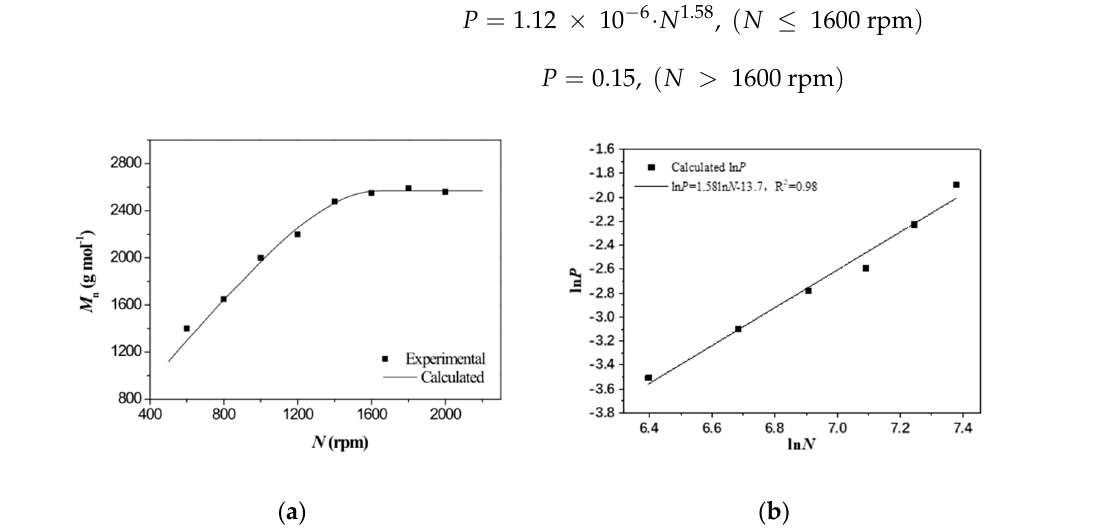
Figure 6. ( a ) Effect of N on the M n of PIB when Q M = 33.7 L·h − 1 , Q I = 6.24 L·h − 1 , [M] t = 2.00 mol·L − 1 , [I] t = 0.22 mol·L − 1 and T = 283 K. ( b ) Linear fitting of ln P versus ln N for cationic polymerization of IB in RPB. Table 3. The calculated values of P based on N and experimental M n